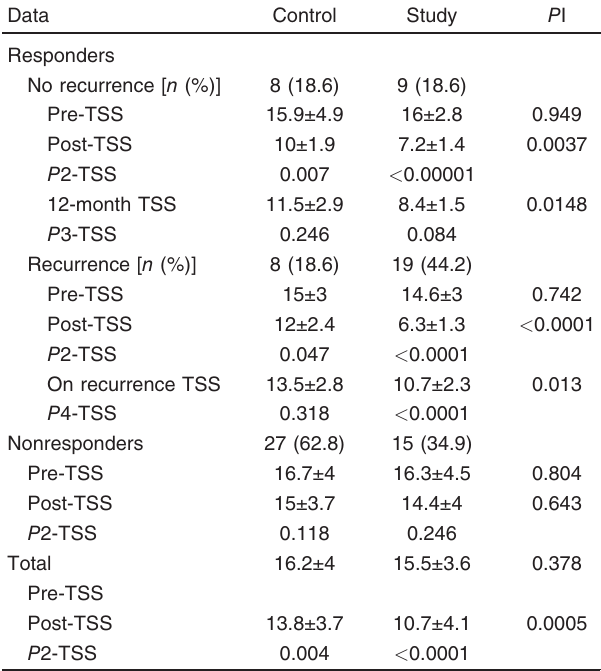
Data are shown as mean±SD. I, significance of difference between TSS of both groups; TSS, total subjective score; ttt, treatment. P 2: indicates significance of difference between pre-ttt and post-ttt TSS. P 3: indicates significance of difference between pre-ttt TSS and at 12-month TSS. P 4: indicates significance of difference between pre-ttt TSS and TSS determined on recurrence of